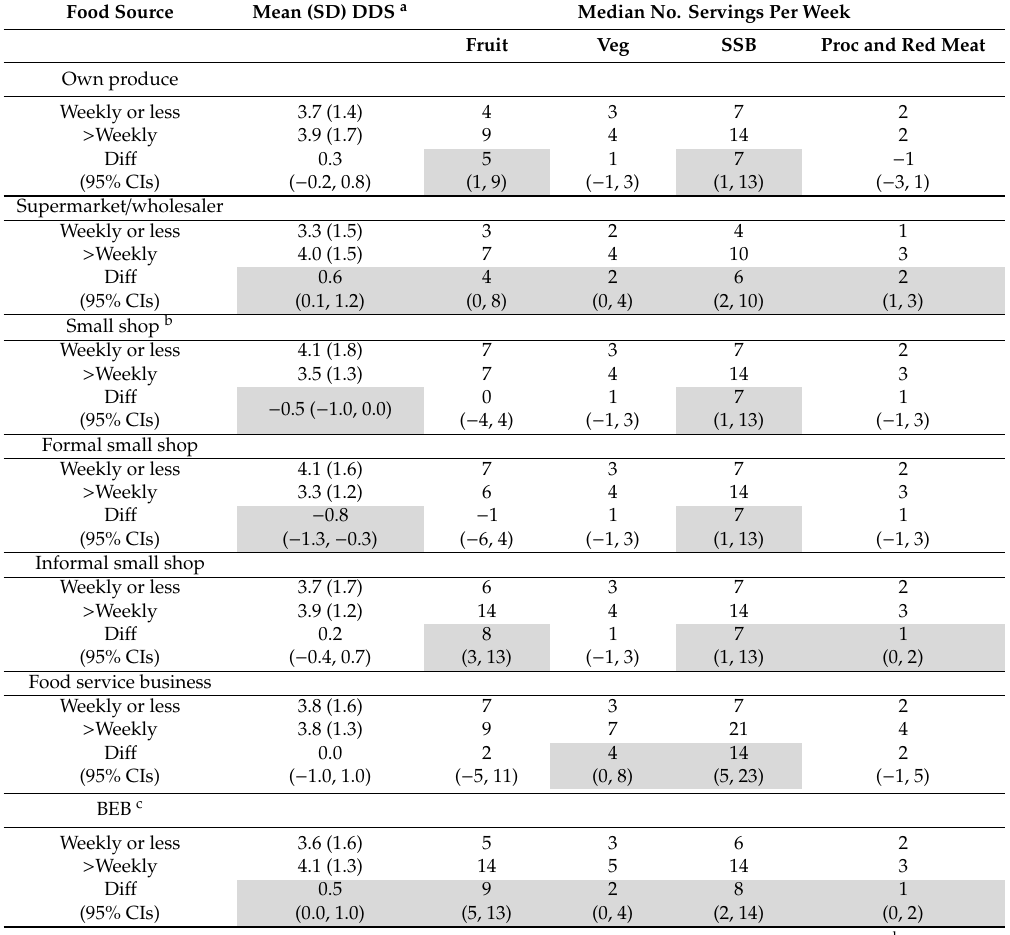
* Shaded cells indicate where the 95% CIs on the di ff erence do not cross zero; a dietary diversity score; b formal and informal; c borrow, exchange or